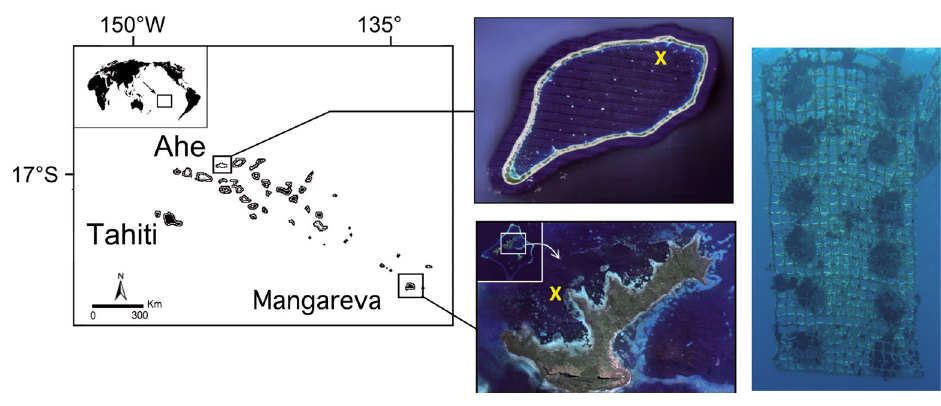
Fig. 1. Geographic loca- tion of Ahe and Man- gareva. Crosses show the sites where sampling took place. The photo on the right represents a kanga- roo net suspended on a